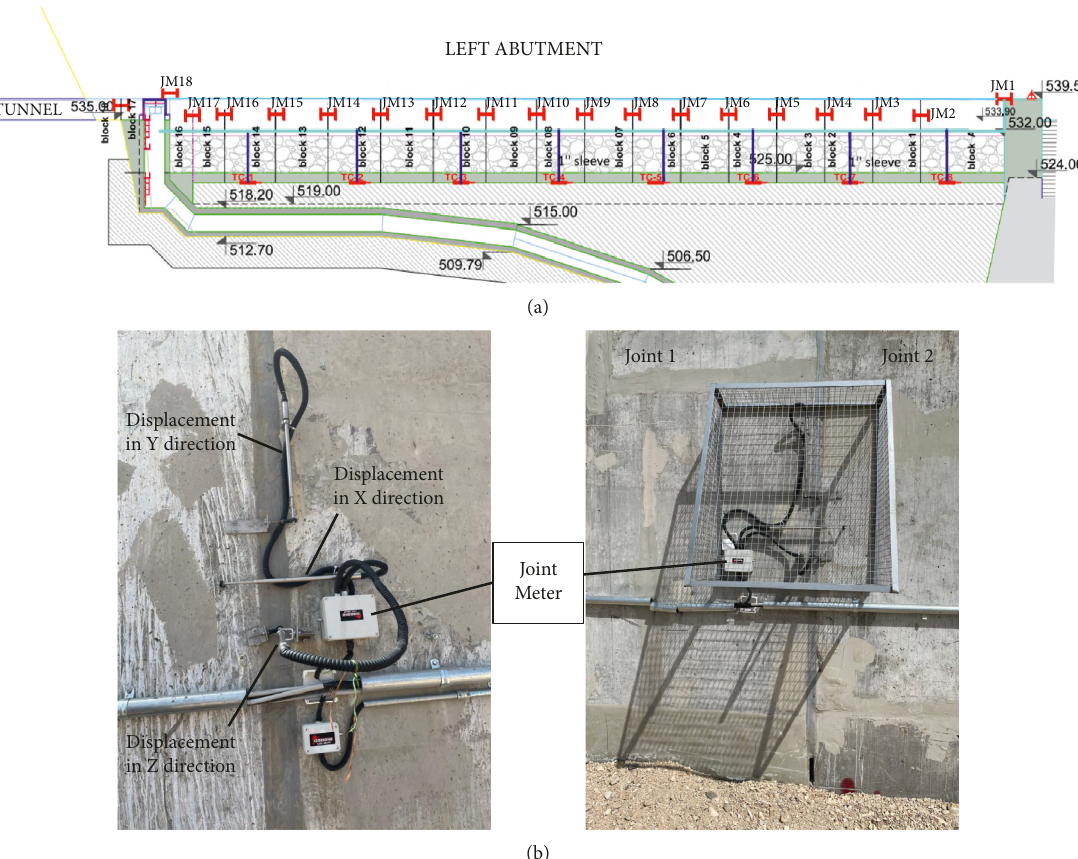
Figure 22: (a) Location of joint meters at left abutment and (b) photo of the joint